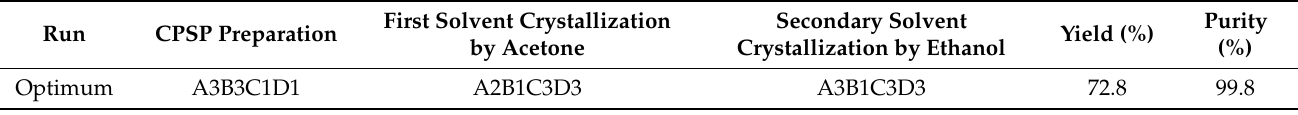
Table 2. Confirmation of the yield and purity of the modified method for producing the pure parapyruvate crystals with the optimal